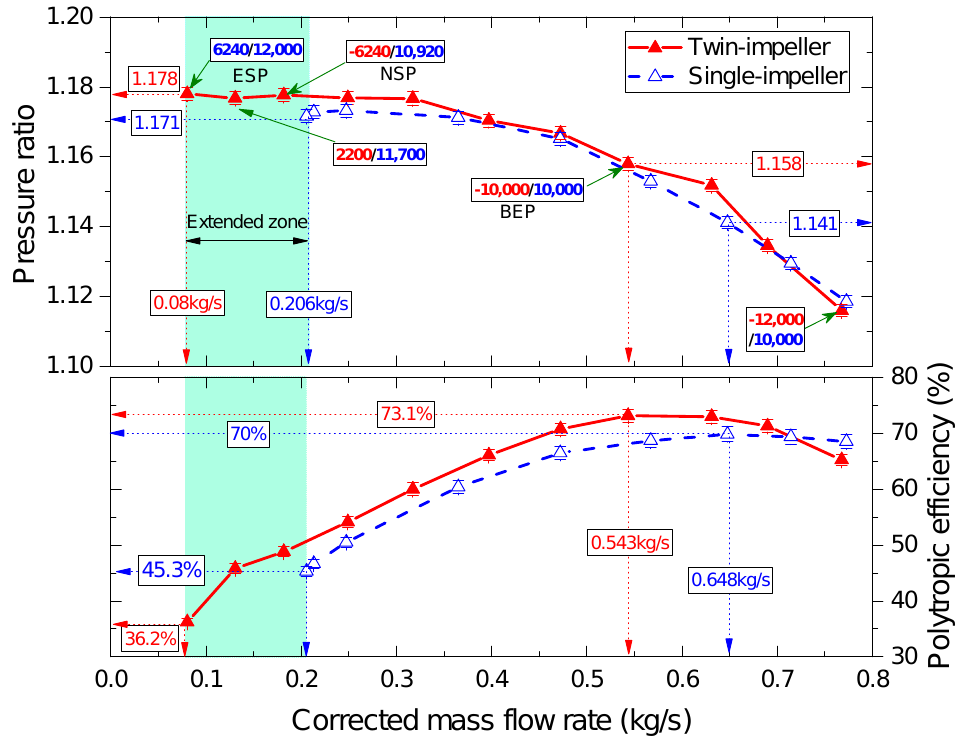
Figure 3. Comparison of performance between TICC and SICC in case of simultaneous impeller speed changes: red solid line represents the TICC performance and blue dashed line depicts the SICC one at 11k